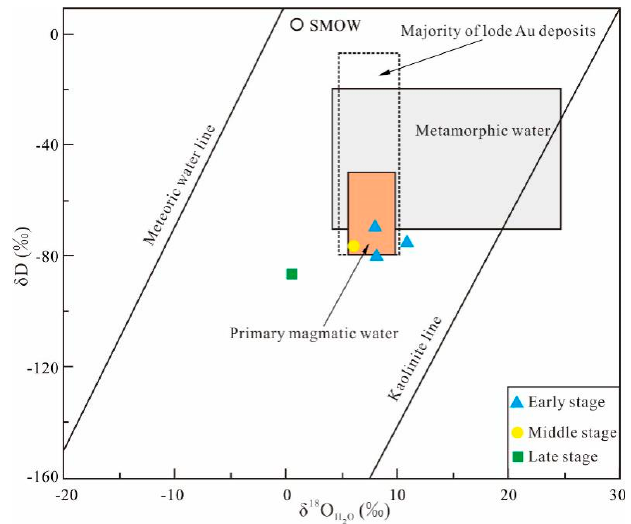
Figure 12. δ D versus δ 18 O H 2O plot of the isotopic compositions of the ore-forming fluids from the Liyuan gold deposit (following Reference [75]).